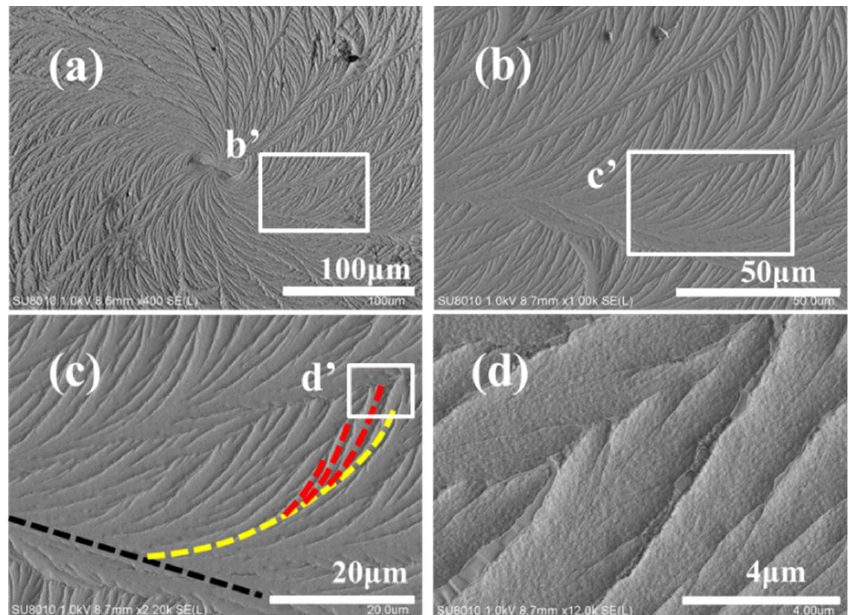
Figure 8. ( a ) SEM micrographs: ( b – d ) enlarged images of the square regions—b’, c’, and d’ for (R)-MA/PVPh (50/50) dendritic spherulite crystallized at T c = 45 °C. A comparison of POM and SEM micrographs of crystallized (R)-MA/PVPh (50/50)